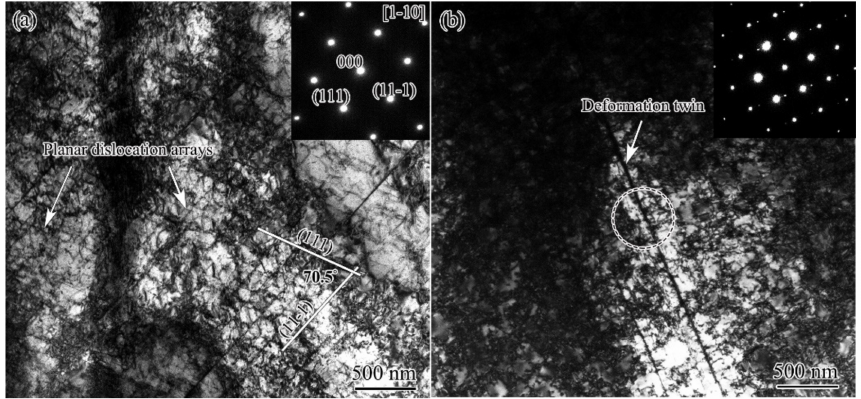
Figure 5. TEM observation of the microstructure of DS ( a ) and CTS ( b ) of the USRT AISI 304 stainless steel